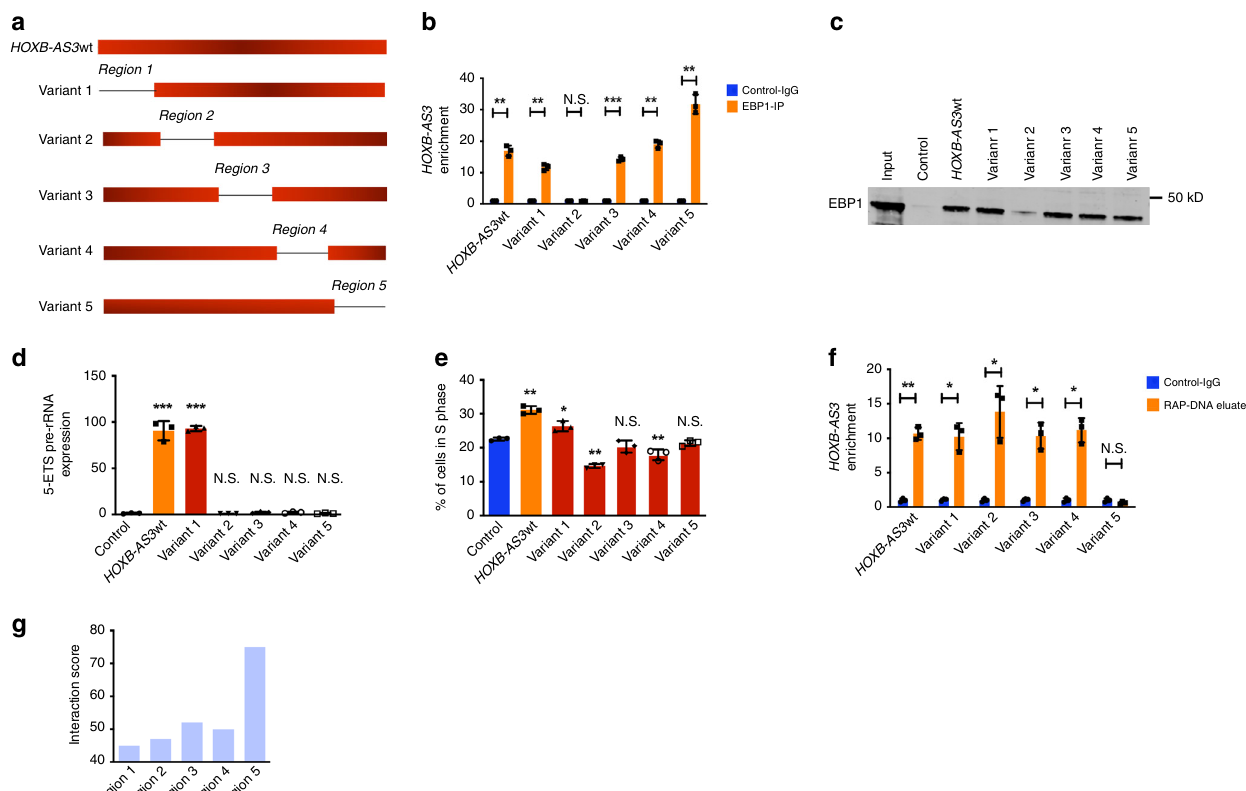
Fig. 6 Characterization of the HOXB-AS3 region which mediates the interaction with EBP1. a Schematic representation of truncated HOXB-AS3 variants 1 – 5, compared with wild-type HOXB-AS3 ( HOXB-AS3 wt). The truncated regions are also annotated (1 – 5). b EBP1-targeting RIP experiments in K-562 cells overexpressing HOXB-AS3 wt or truncated HOXB-AS3 variants 1 – 5. The amount of HOXB-AS3 that interacted with EBP1 is depicted as enrichment in comparison to the rabbit IgG control. * P < 0.05, ** P < 0.005, *** P < 0.001, N.S., not signi fi cant. c Western blotting for the EBP1 protein after incubation of nuclear lysates of K-562 cells with biotinylated HOXB-AS3 wt or truncated HOXB-AS3 variants 1 – 5. d Relative pre-rRNA expression in K-562 cells overexpressing HOXB-AS3 wt or truncated HOXB-AS3 variants 1 – 5. *** P < 0.005, **** P < 0.001, N.S., not signi fi cant. e Cell-cycle analysis in K-562 cells transfected with empty vector, HOXB-AS3 wt - or truncated HOXB-AS3- overexpressing vectors. Percentages of cells in the S Phase are shown. ** P < 0.01, **** P < 0.001, N.S., not signi fi cant. f Enrichment of 28S rDNA promoter region in RAP-DNA-based isolation of chromatin in K-562 cells transfected with HOXB-AS3 wt - or truncated HOXB-AS3- overexpressing vectors. Results are depicted as fold change of enrichment in samples treated with control versus HOXB-AS3 -capturing biotinylated probes. * P < 0.05, ** P < 0.01, N.S., not signi fi cant. g In silico analysis of the interaction between the HOXB- AS3 regions and the rDNA promoter. P values were calculated using paired two-sided t -tests. In the fi gures, heights of boxplots indicate mean values